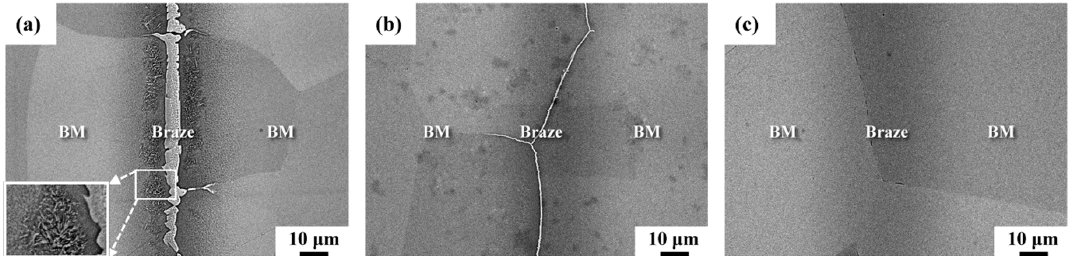
Figure 3. ( a ) Schematic cross section of the clad Ti-15Cu-15Ni foil, ( b ) BSE-SEM micrograph showing the cross section of area I in ( a ) for the clad filler foil, ( c ) compositional line scan of ( b ).